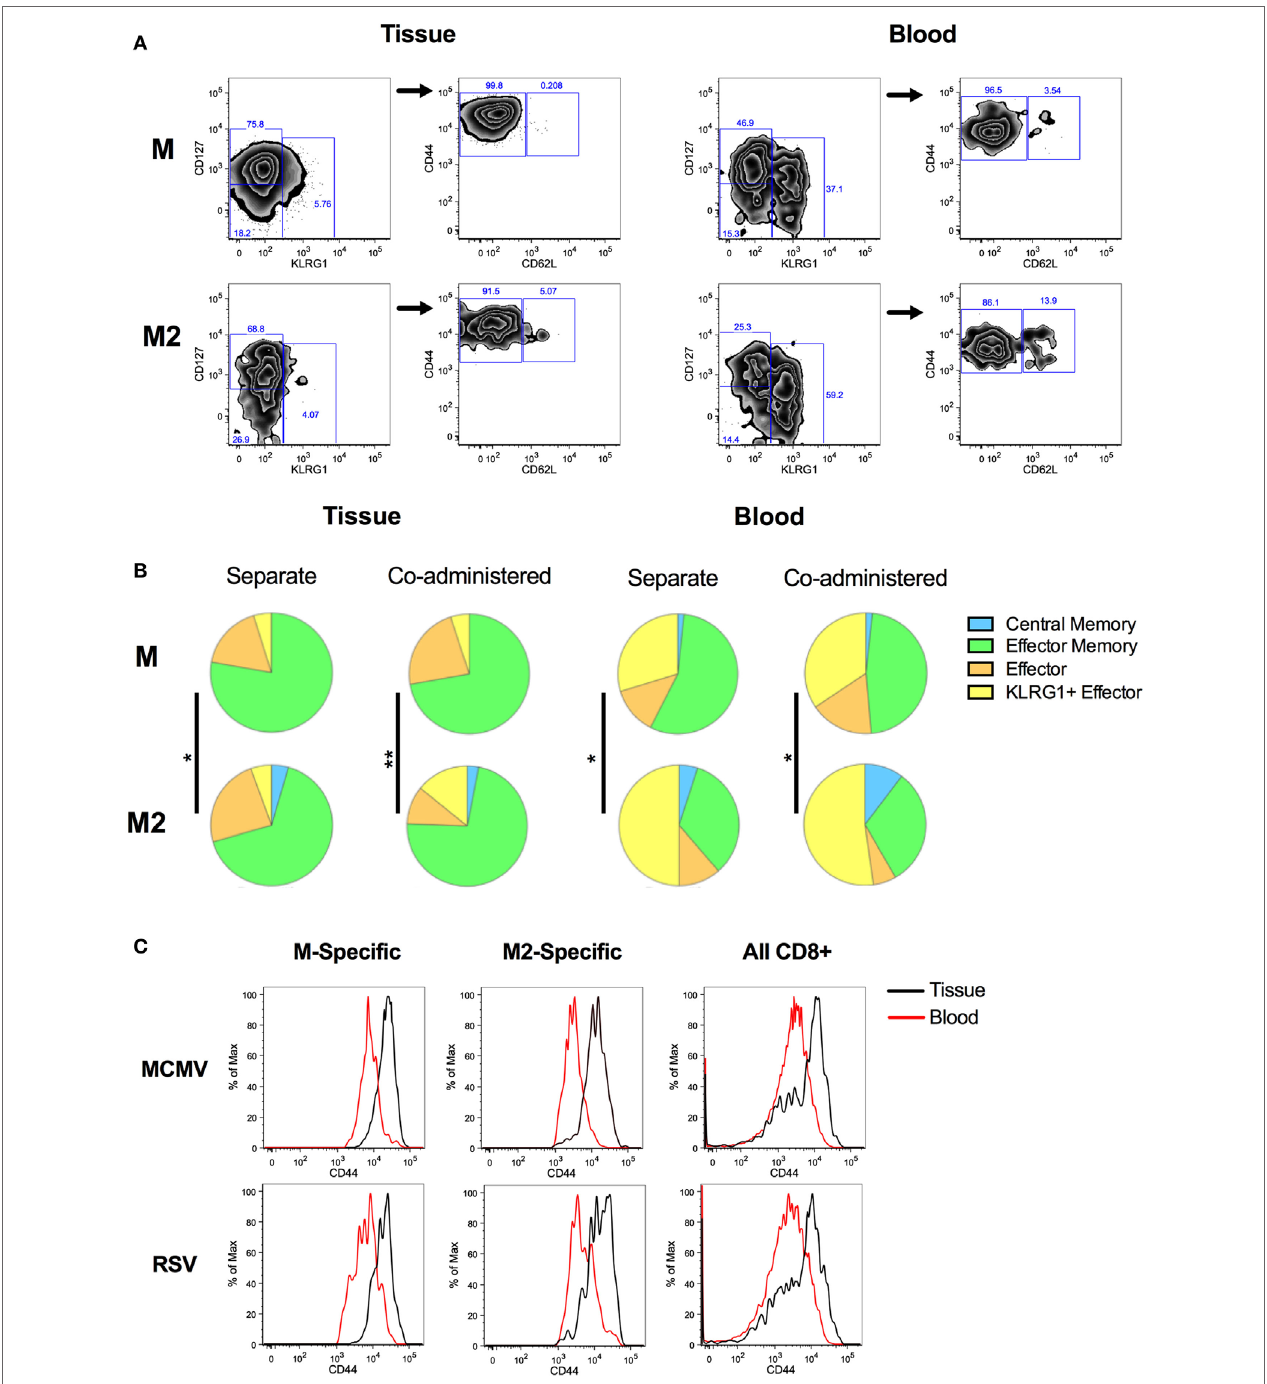
FigUre 5 | Phenotype of M-specific and M2-specific CD8 + T cells elicited by murine cytomegalovirus (MCMV) vaccination. Mice were vaccinated with MCMV-M or MCMV-M2 alone or a combination of MCMV-M and MCMV-M2 via the IN route. Intravascular staining was used in conjunction with D b /M 187–195 and K d /M2 82–90 tetramers to identify M-specific and M2-specific CD8 + T cells in the blood and tissue of the lungs at week 8. (a) Gating strategy for phenotypic analysis. Populations were defined as follows: CD127 + KLRG1 − CD62L + [central memory (CM)]; CD127 + KLRG1 − CD62L − [effector memory (EM)]; CD127 − KLRG1 − CD62L − (effector); and KLRG1 + CD62L − (KLRG1 + effector). (B) The proportions of CM cells (blue), EM cells (green), effectors (orange), and KLRG1 + effectors (yellow) in the lungs are shown for each specificity. (c) CD44 expression on M-specific, M2-specific, and all CD8 + T cells in the tissue and blood of the lungs. * P ≤ 0.05, ** P < 0.01 by permutation test (SPICE). Data are shown from one experiment ( n = 5/group) and representative of two independent